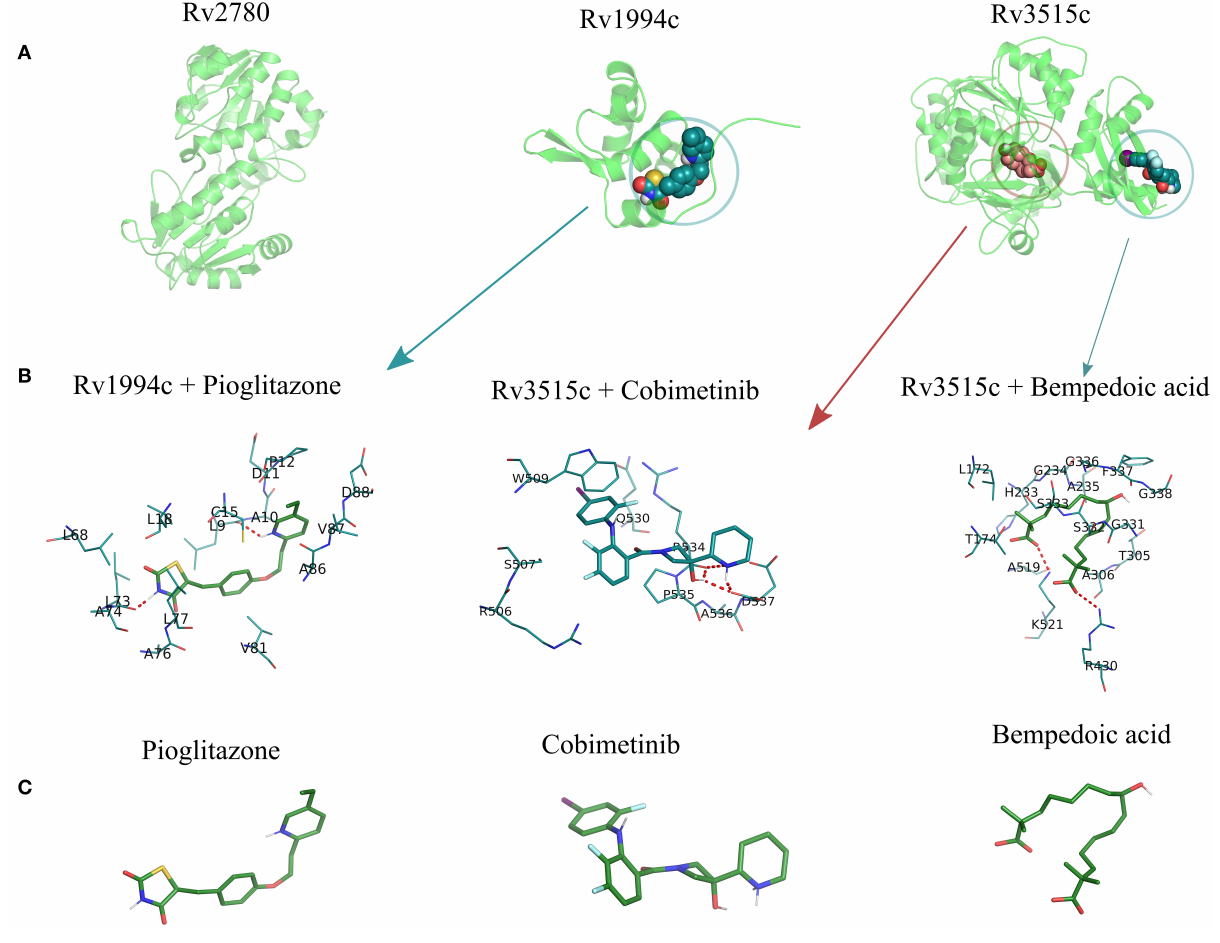
FIGURE 6 | The structural model of the three shortlisted target candidates predicted along with the pocket identified from the consensus approach. (A) The structures predicted for each of the 3 proteins, i.e., ald (Rv2780), cmtR (Rv1994c), and fadD19 (Rv3515c), are represented in cartoon format. (B) The docking pose of the best drugs for the targets. fadD19 (Rv3515c) is docked against Bempedoic acid and Cobimetinib, while cmtR (Rv1994c) is docked with Pioglitazone. No drug hits are identified for ald (Rv2780). (C) Three-dimensional structures of the 3 docked